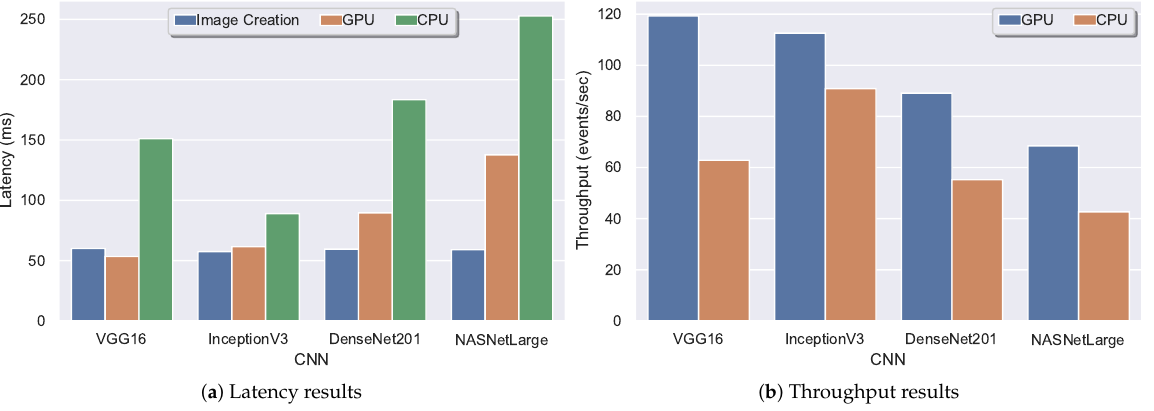
Figure 19. Execution performance experiments with and without the